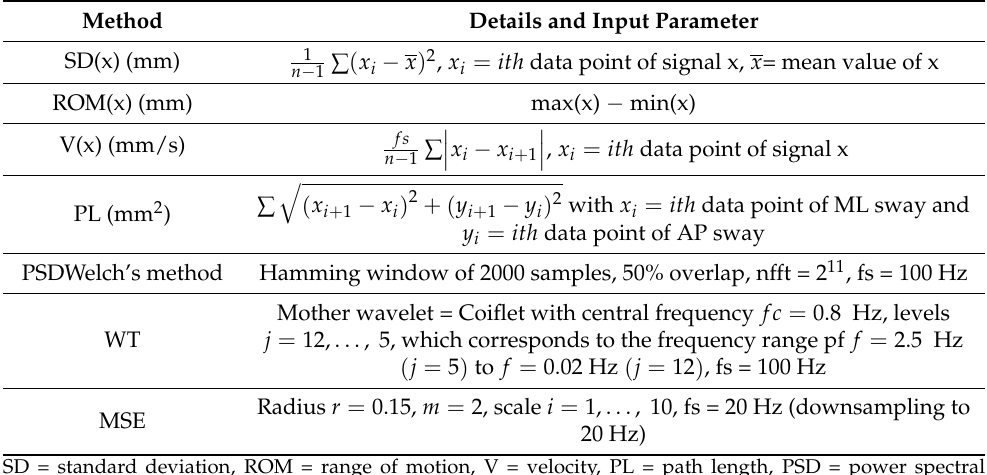
Table A1. Details and input parameters for the different methods applied to the center-of-pressure